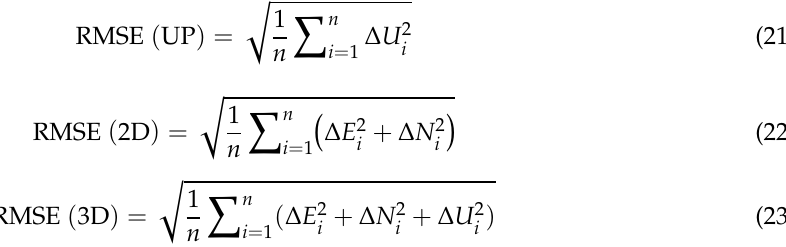
Figure 10. Pedestrian trajectory obtained by the proposed algorithm expressed in local reference system. Let ∆ Ei, ∆ Ni and ∆ Ui the errors in the East, North and Vertical components of the i -th position estimate sample. The RMS vertical, horizontal (2-D) and 3-D errors are defined as: